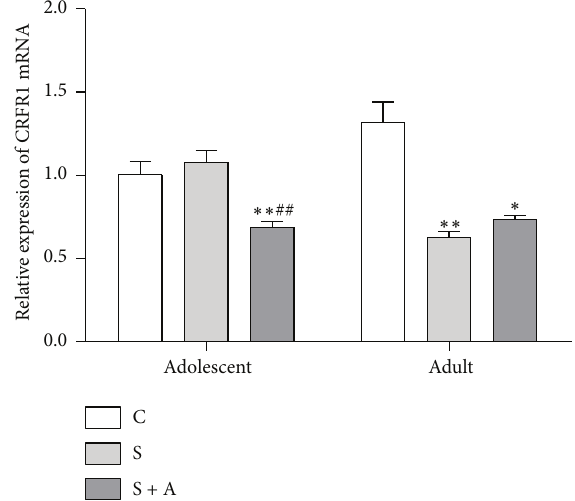
Figure 5: Relative expression of CRFR1 mRNA in adolescent and adult hypothalamus. Values were expressed as mean ± SEM. ∗ and ∗∗ indicate 𝑝 < 0.05 and 𝑝 < 0.01 versus CON, respectively; ## indicates 𝑝 < 0.01 versus S.